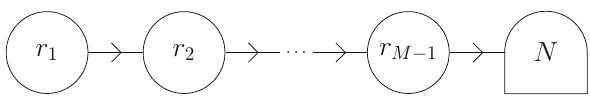
Fig. 1 The quiver which describes the generic surface operator in pure SU ( N ) gauge theory